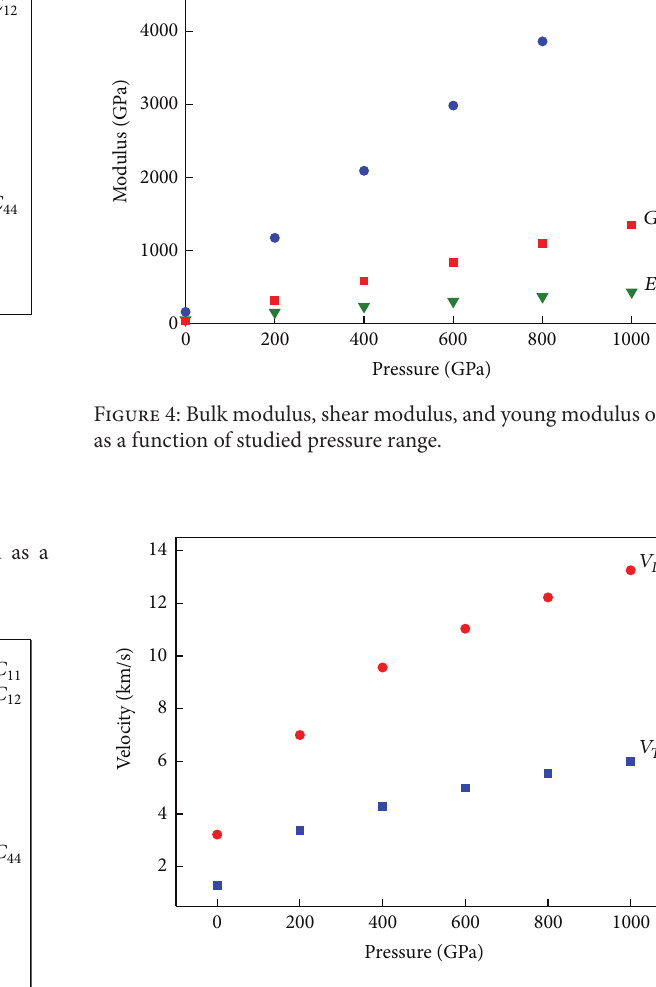
Figure 5: 𝑉 𝐿 and 𝑉 𝑇 behavior of Au under pressure up to 1000GPa.